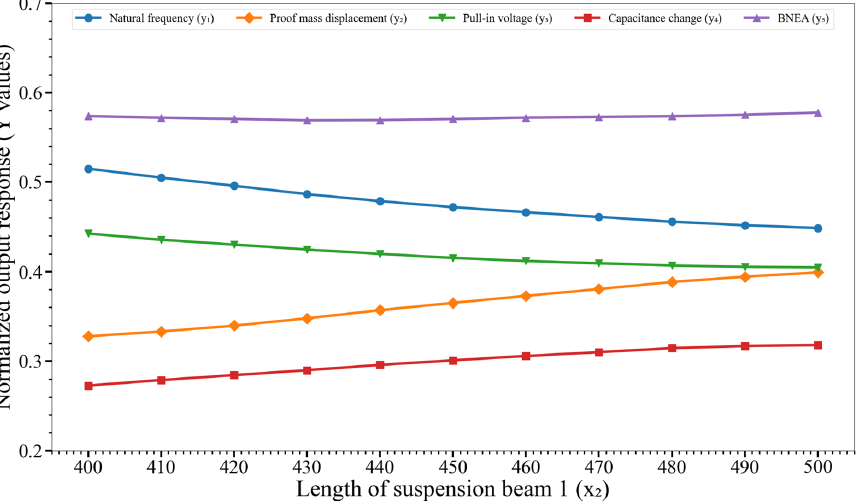
Figure 8. Effect of variation of the length of the suspension beam 1 (x 2 ) on the output responses y 1 , y 2 , …, y 5 . Key. y 1 : natural frequency; y 2 : proof mass displacement; y 3 : pull-in voltage; y 4 : capacitance change; and y 5 : BNEA.